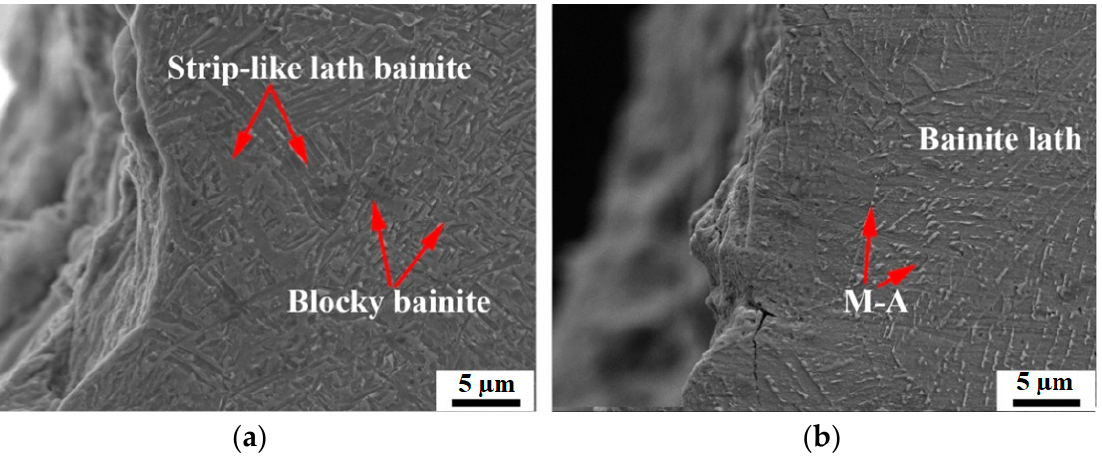
Figure 5. SEM microstructure at prefabricated fatigue crack tips using two heat inputs: ( a ) ultra-low heat input; ( b ) conventional heat input.